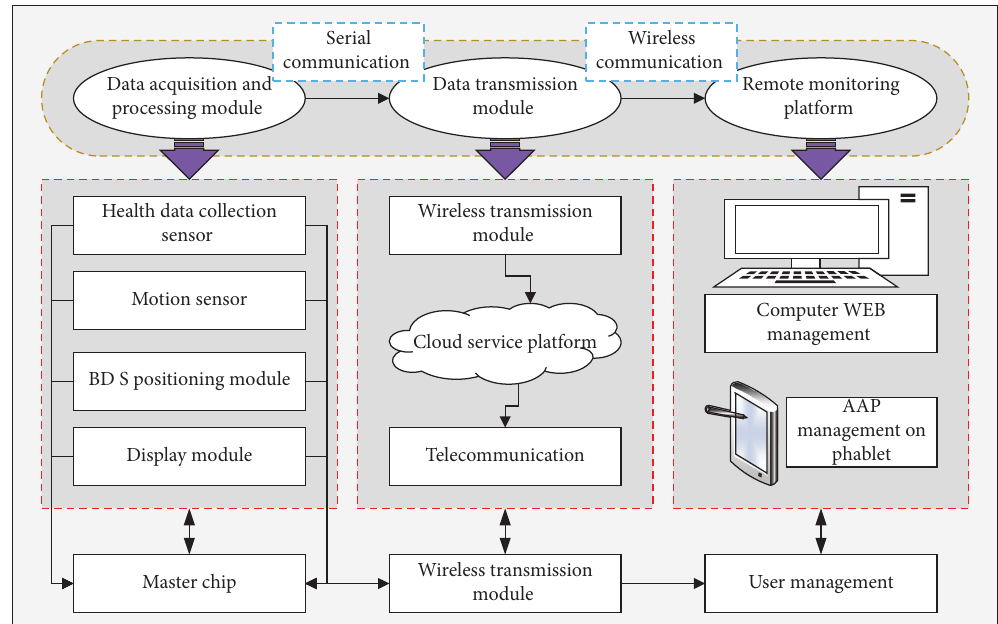
Figure 1: General scheme